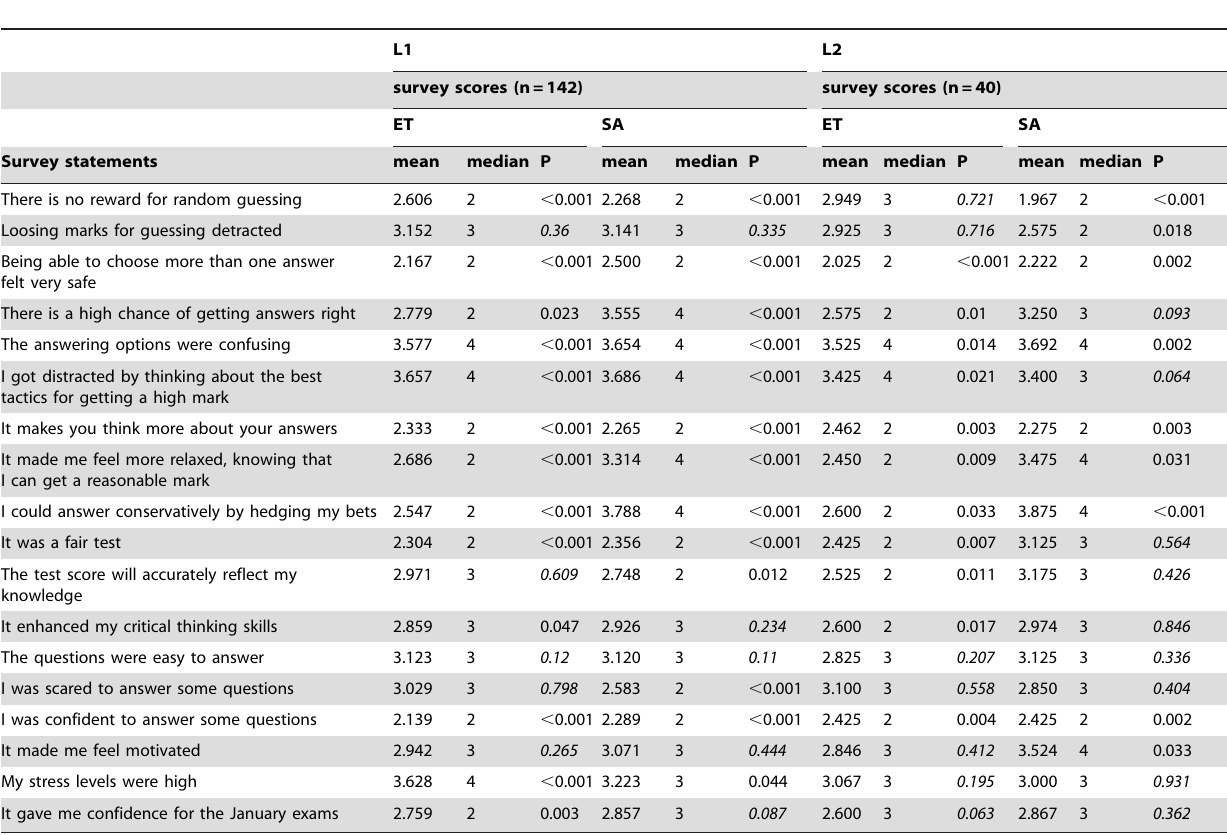
Table 3. L1 and L2 student responses immediately after sitting of the ET and SA tests on a 6 item Likert scale (survey scores).